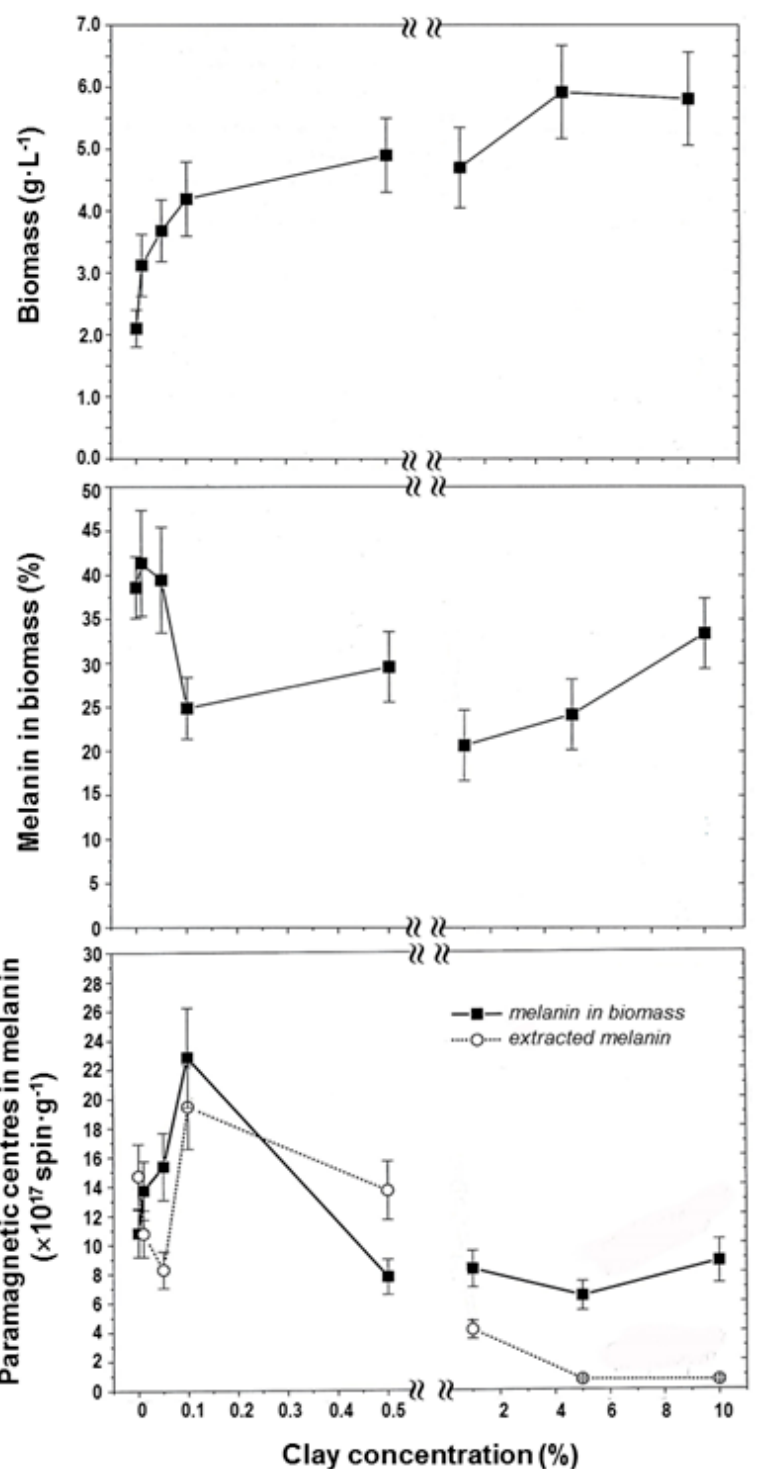
Figure 5. Effects of montmorillonite concentration on the biomass yield, melanin concentration in biomass and the electron paramagnetic resonance intensity in both melanin in biomass and extracted melanin of Cladosporium cladosporioides 396 [206].